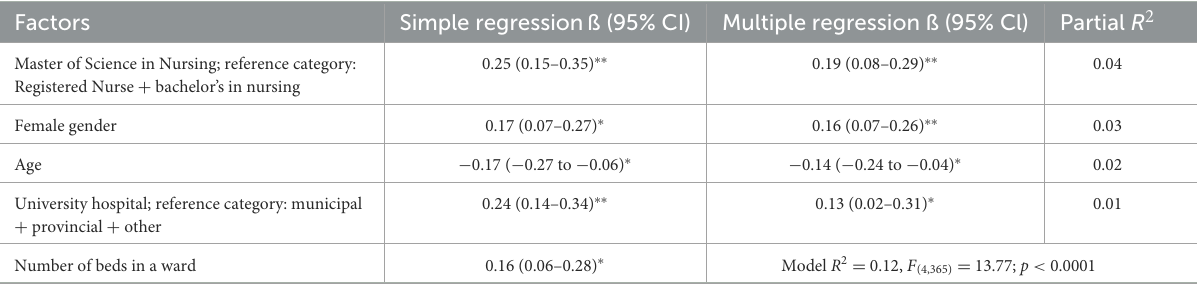
TABLE 3 Multiple linear regression analysis for variables predicting for nurses’ knowledge of delirium.